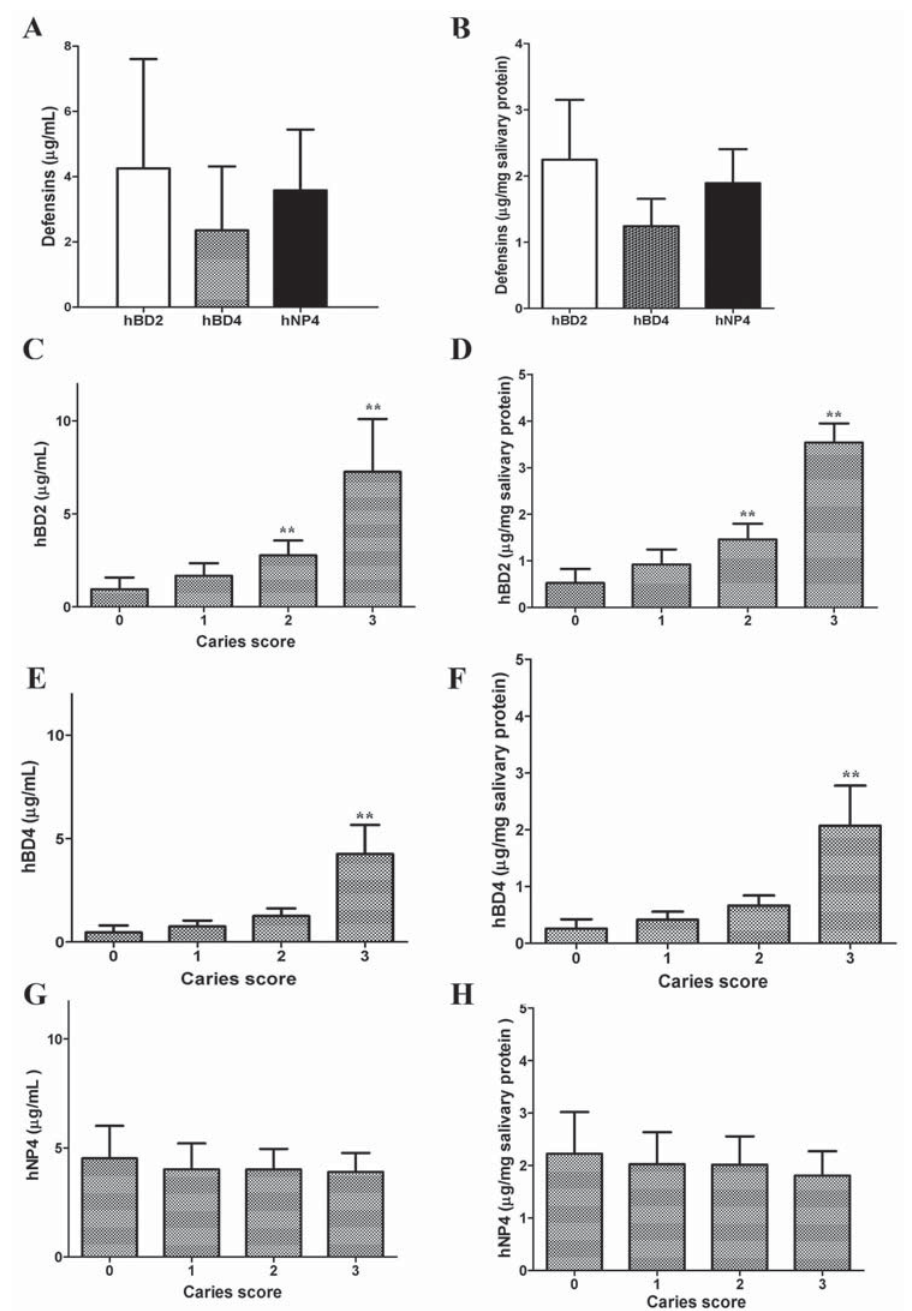
FIGURE 2. Defensins levels in saliva as a function of caries score. Saliva was thawed and cleared by centrifugation twice at 3000 x g for 20 min at 4°C, proteins were precipitated with HCl-TCA. Defensins concentrations were determined by ELISA us- ing anti-hBD2, anti-hBD4, or anti-hNP4 as primary antibody, as indicated in Materials and methods (12). The fi gure shows the measured concentrations of defensins expressed as μ g/ml (A), and relative to salivary protein in μ g/mg protein (B). hBD2, hBD4 and hNP4 concentrations in saliva, expressed as μ g/ml; (C, E and G) and relative to salivary protein in μ g/mg protein (D, F and H). The caries group showed signi fi cantly higher hBD2 and hBD4 concentration (A and B) than each of the groups with no caries (**, P<0.01). Each assay was carried out in three independent experiments, and results are reported as